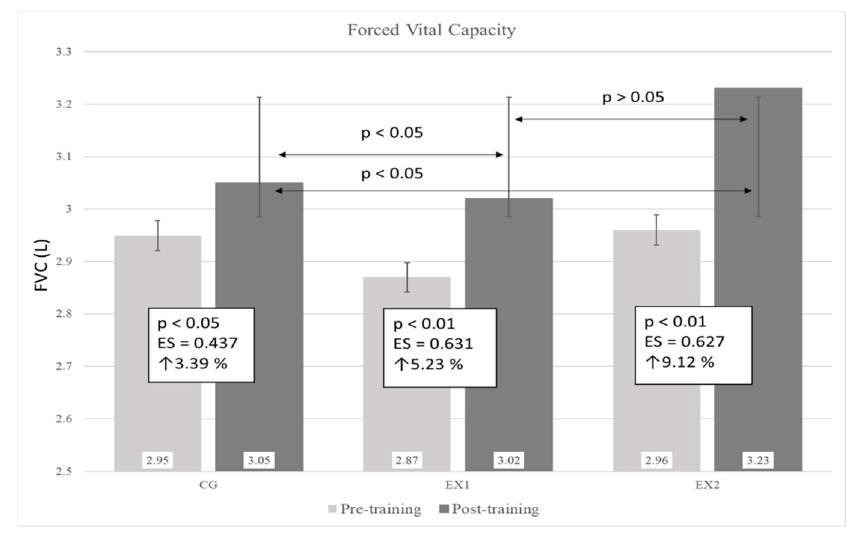
Figure 1. Force vital capacity.